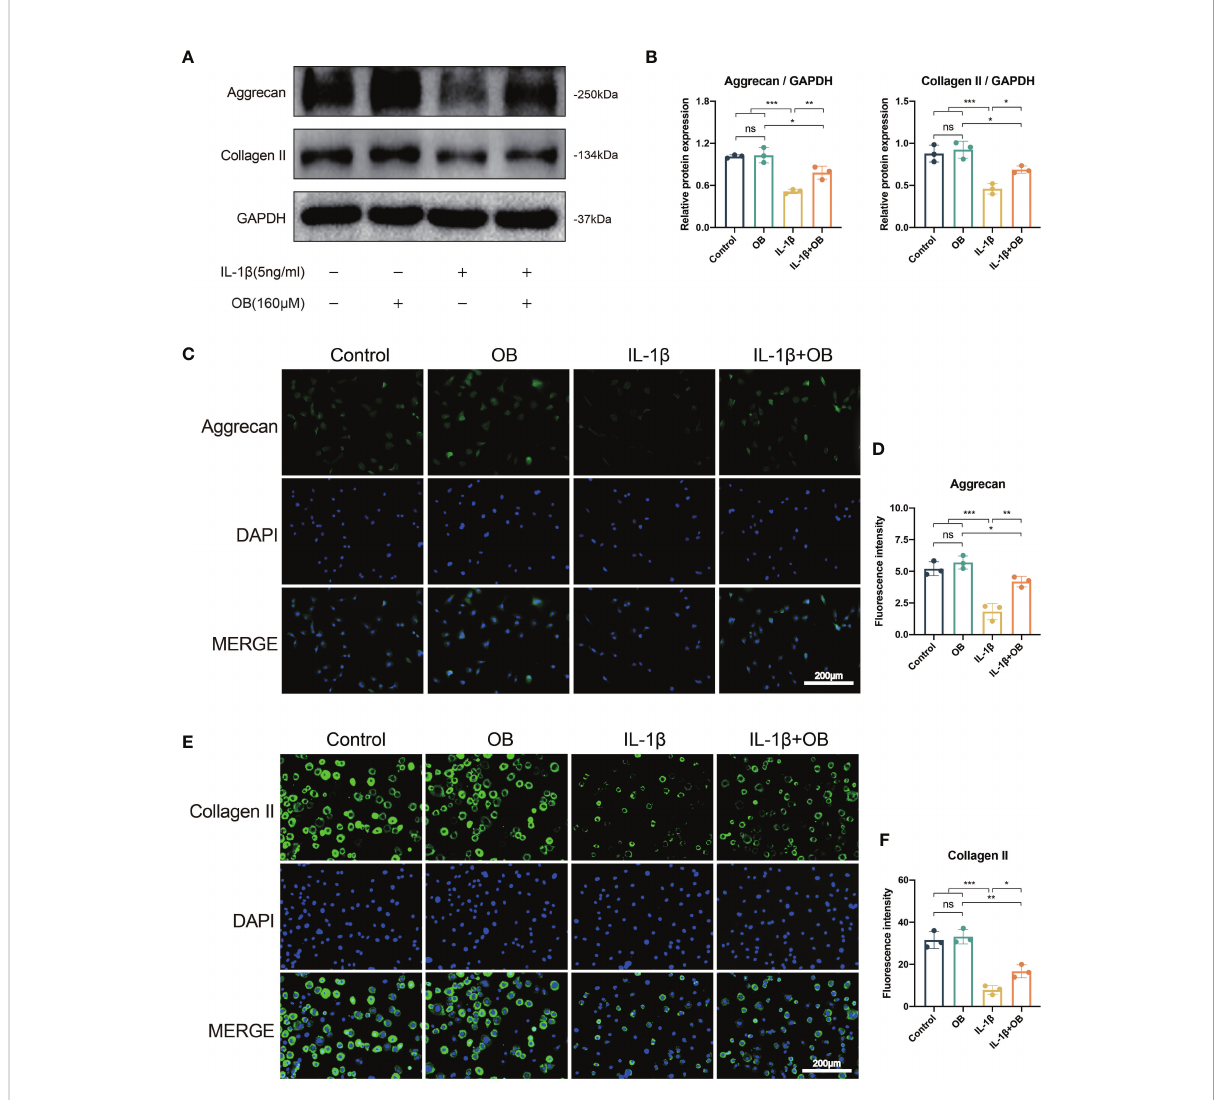
FIGURE 2 OB upregulated the anabolism in IL-1 b – induced chondrocytes. Chondrocytes were treated with IL-1 b (5 ng/ml) or/and OB (160 m M) for 24 h. (A) Western blot analysis and (B) quantitative data for the key anabolic-related proteins (Aggrecan, Collagen II). (C, E) Immuno fl uorescence staining and (D, F) quantitative data of the expression levels of Aggrecan and Collagen II. Data were presented as means ± SD (n = 3). ns, no signi fi cance; * p < 0.05; ** p < 0.01; *** p <